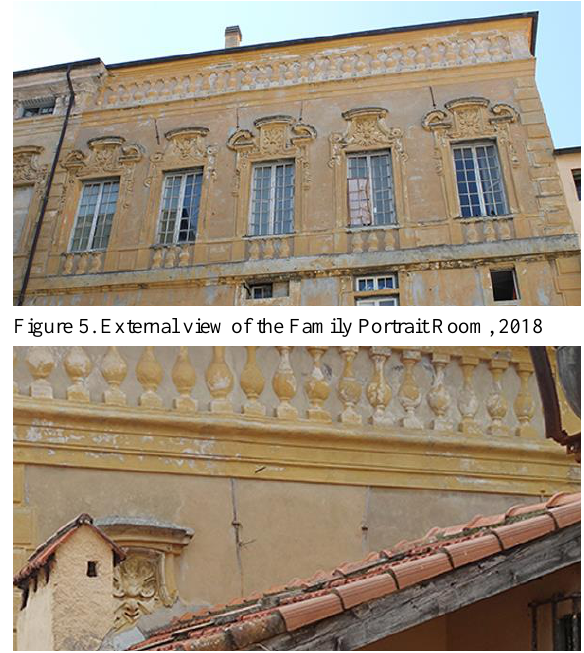
Figure 6. External view of the Family Portrait Room,